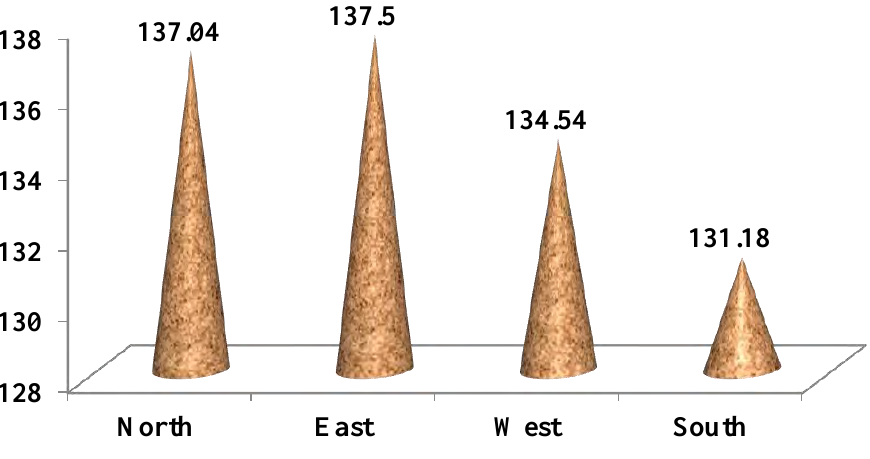
Figure 4. Graphical representation of mean scores with regard to North, East, West and South regions female baseball players on the parameter Emotional Intelligence